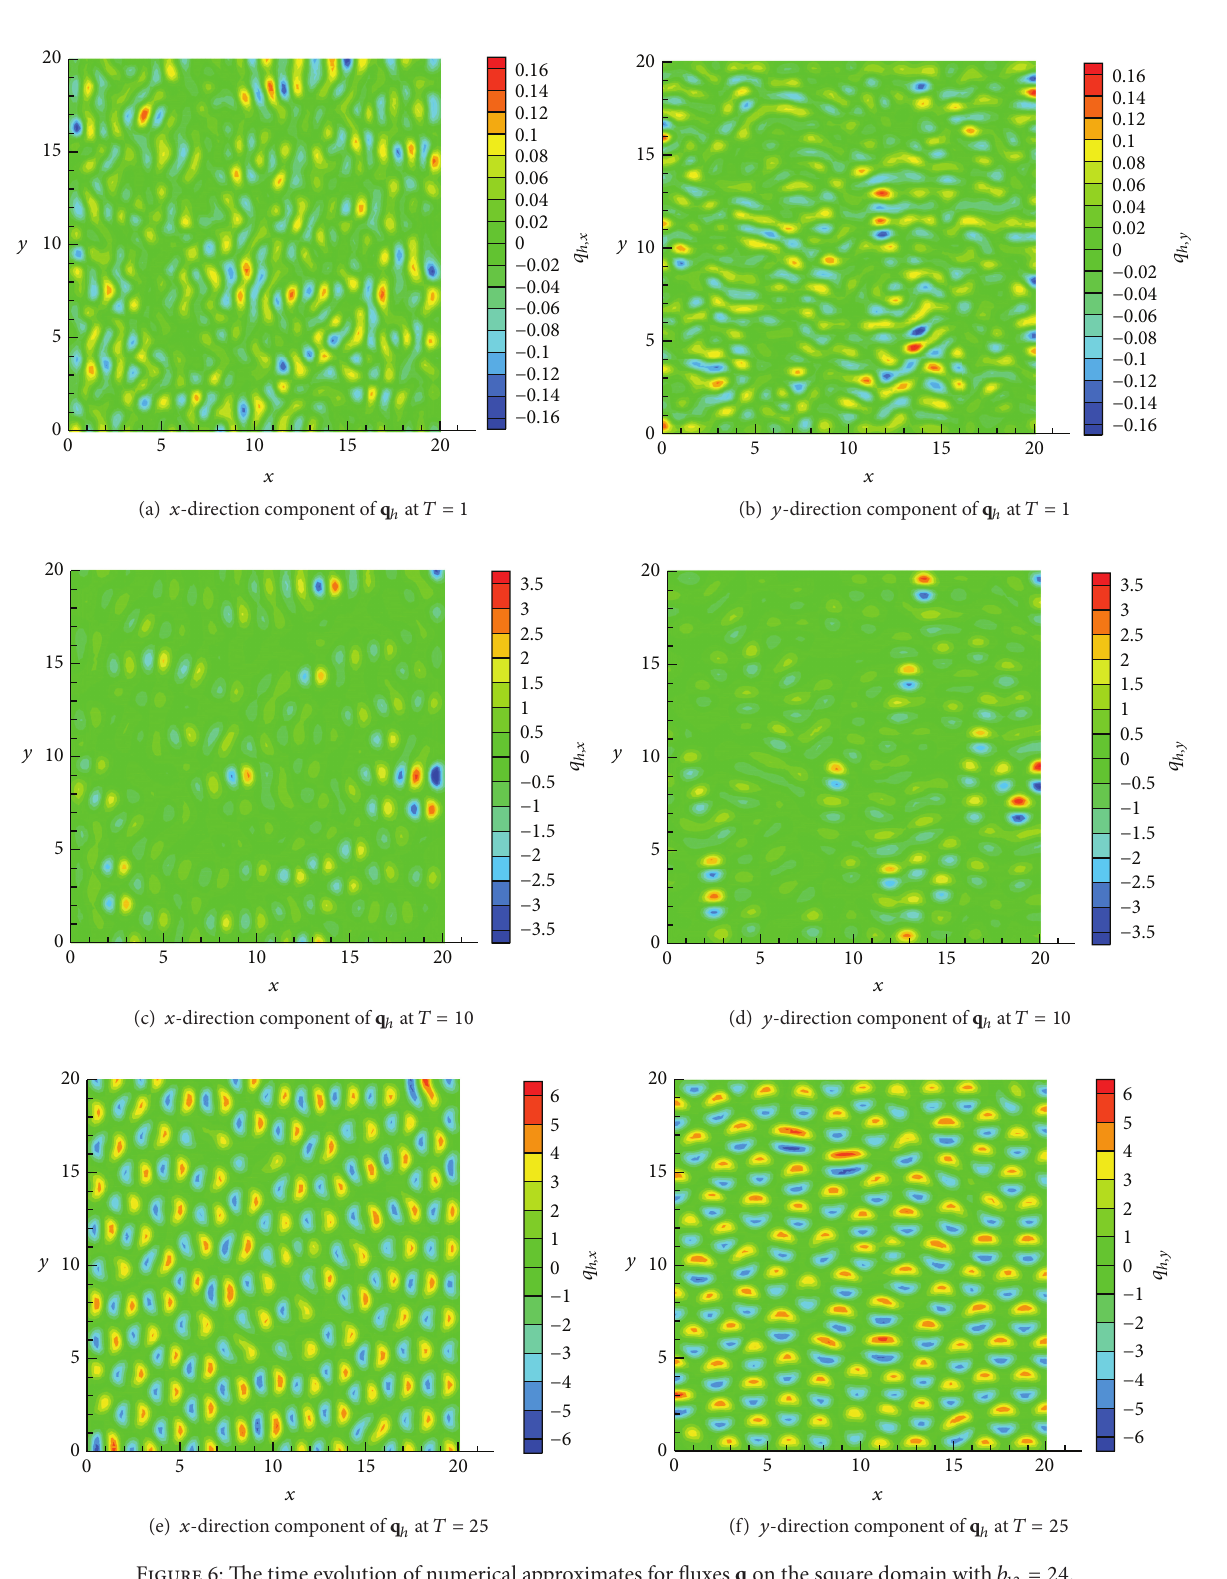
Figure 6: The time evolution of numerical approximates for fluxes q on the square domain with 𝑏 12 = 24